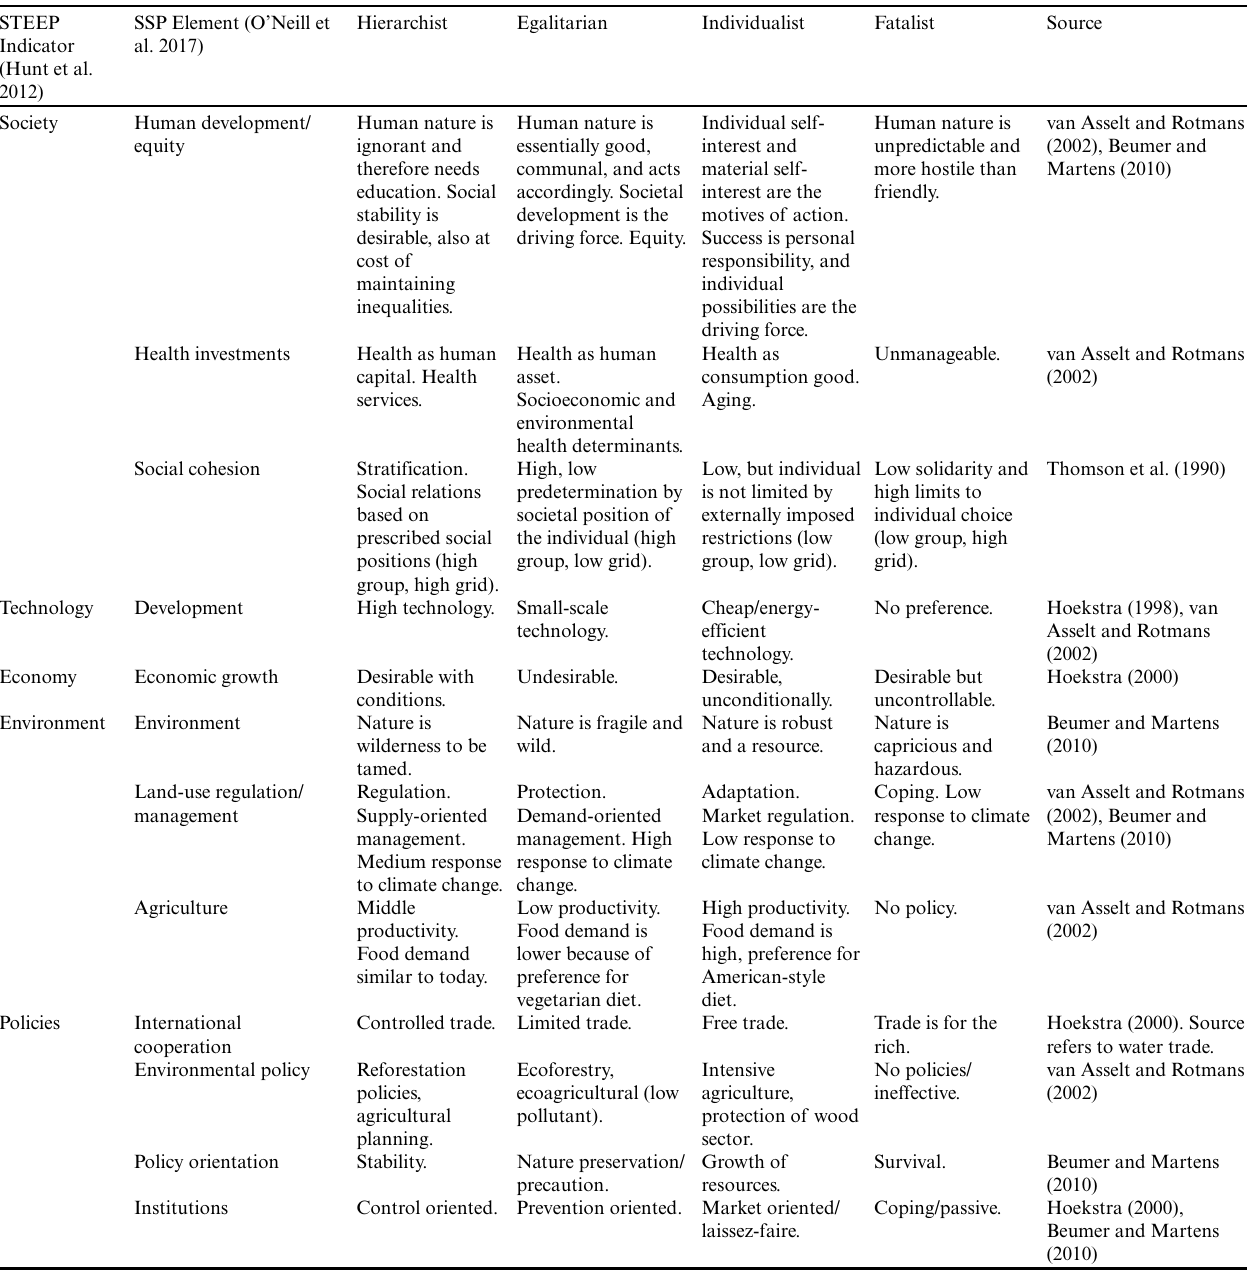
Table 1 . Statements on socioeconomic, technology, economy, environment, and policy (STEEP) indicators, selected from the shared socioeconomic pathways (SSPs) scenario element. The statements are interpretations for each element according to four worldviews: hierarchist, egalitarian, individualist, and fatalist. Each statement refers to published literature, listed in the “Source” column.